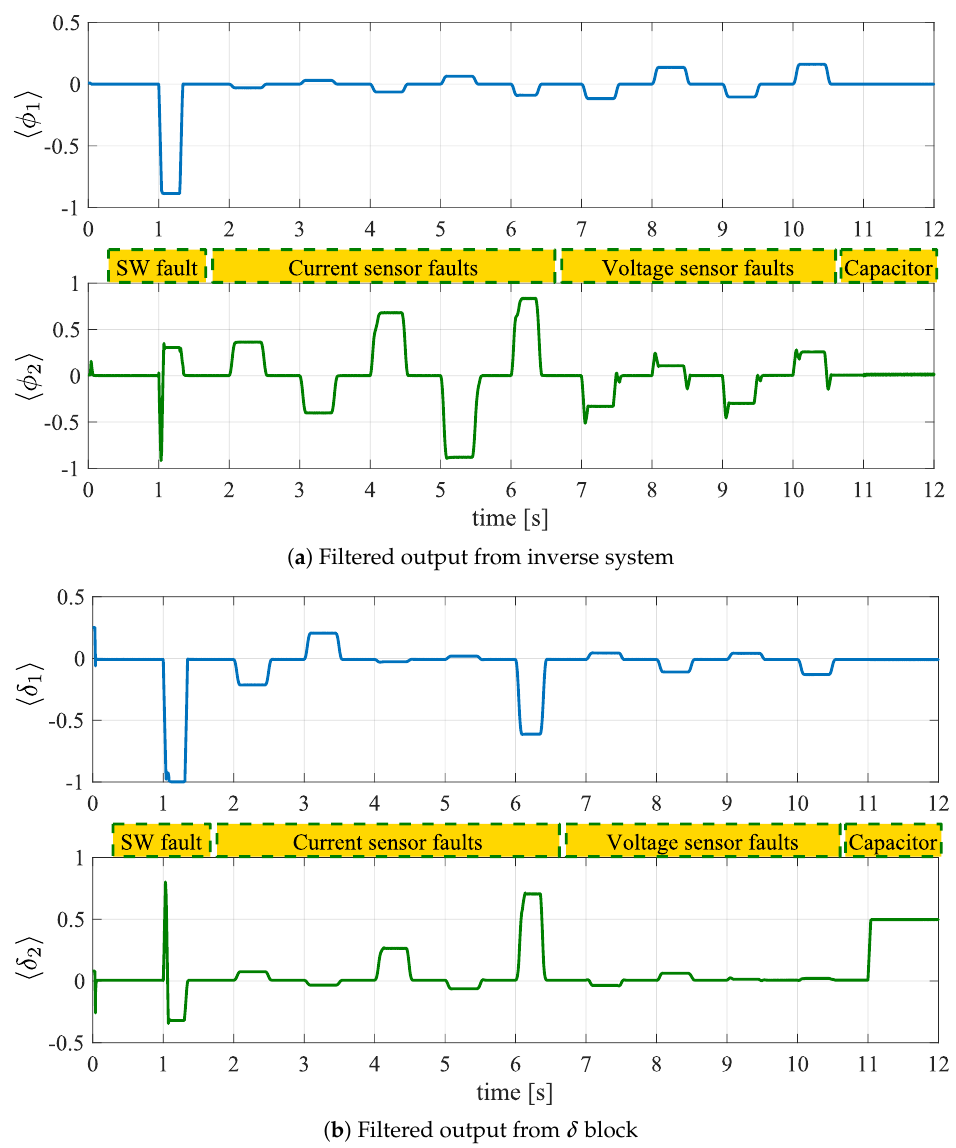
Figure 10. Boost converter simulation: generated signals for R o = 35 Ω